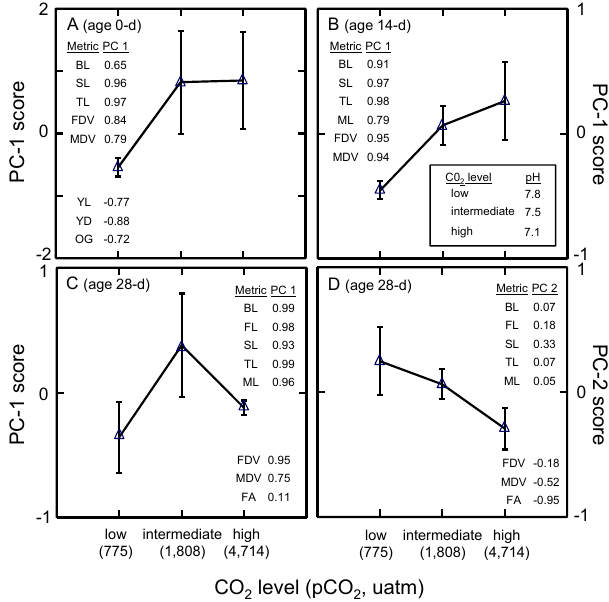
Fig. 4. Responses in size, shape, and development of summer floun- der larvae by age at different levels of CO 2 in rearing water (in- set: associated pH values). Responses are summarized by principal component (PC) scores. Only significant PC axes are shown. (A) 0dph, PC 1. (B) 14dph, PC 1. (C) 28dph, PC 1. (D) 28dph, PC 2. The PC loadings on each original measurement (metric) are shown at each age within panels. Data plotted are means ± SE. See Fig. 1 for abbreviations and Table S2 for summary